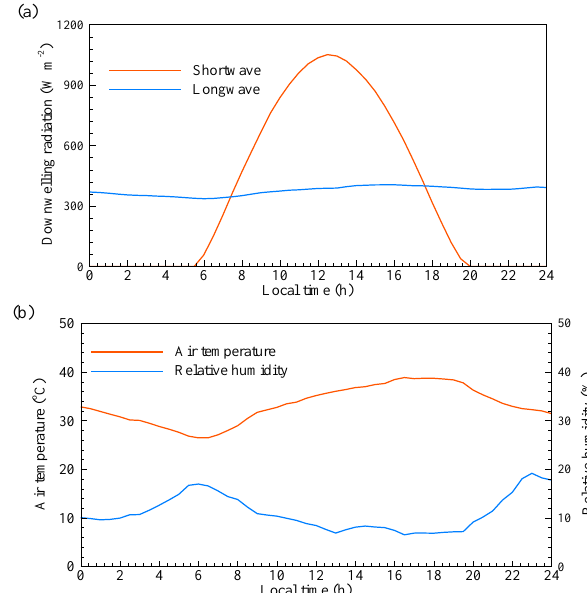
Figure 5. The diurnal surface atmospheric forcing of 14 June 2012 (a clear day) in Phoenix, AZ: (a) downwelling shortwave and long- wave radiation and (b) air temperature and relative humidity. The daytime data between starting point (06:00LT) and ending point (19:30LT) are used to drive the SLUCM–SCM under convective